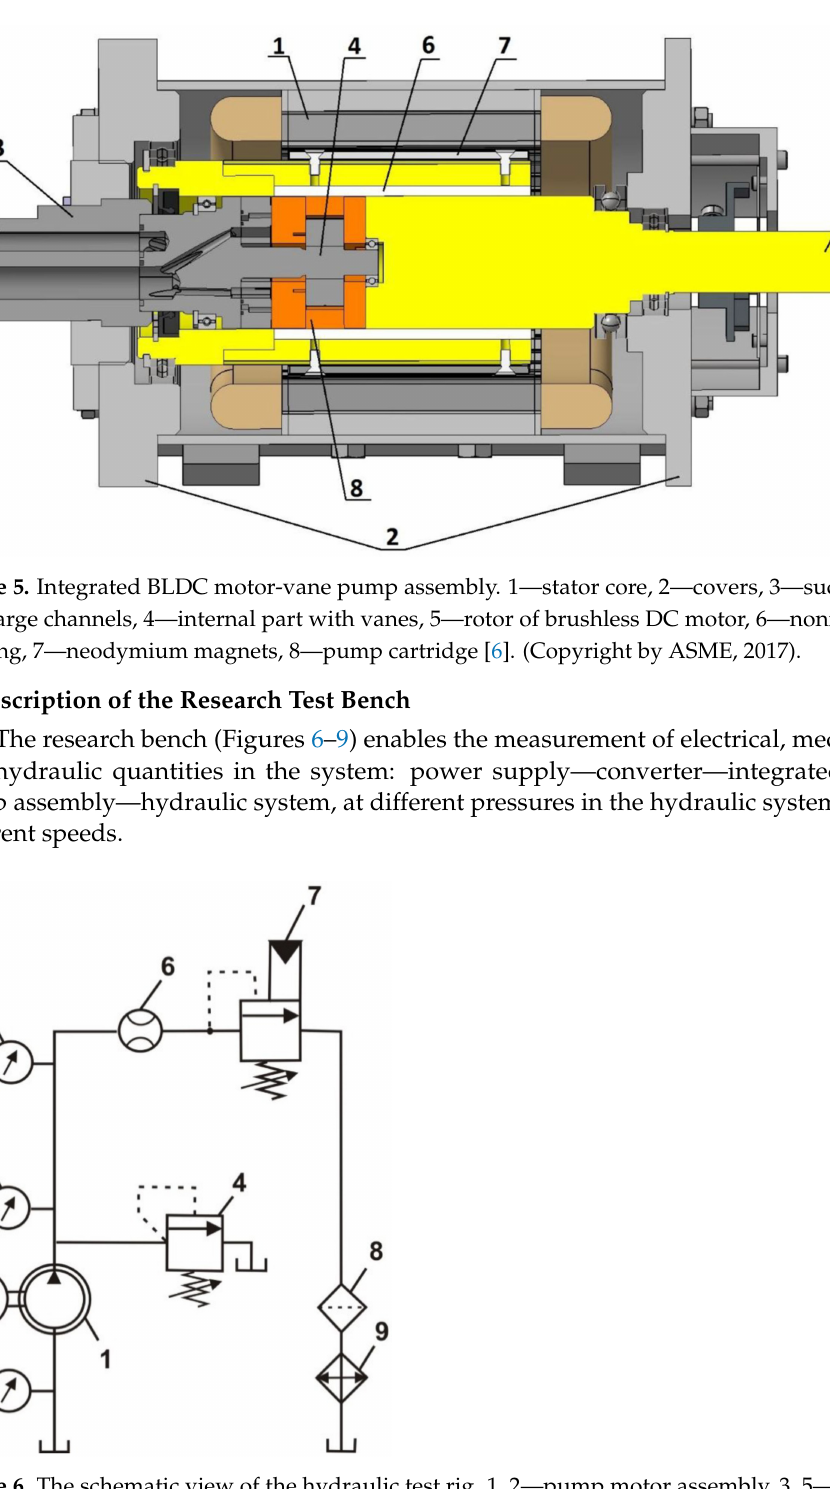
Figure 6. The schematic view of the hydraulic test rig. 1, 2—pump motor assembly, 3, 5—pressure gauge, 4—pressure relief valve, 6—flow meter, 7—pressure relief valve, 8—filter,